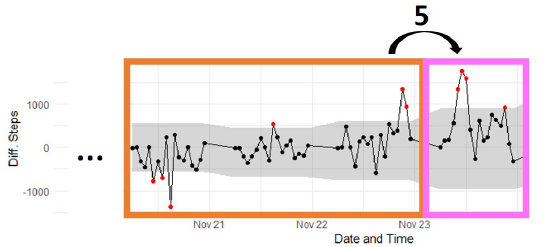
Figure 3. Illustration of Step 5 of U-BEHAVED algorithm. Arrow and number represent Step 5 and coloured boxes highlight relevant processes. X − axis indicates time (in hours). Y − axis is difference in step